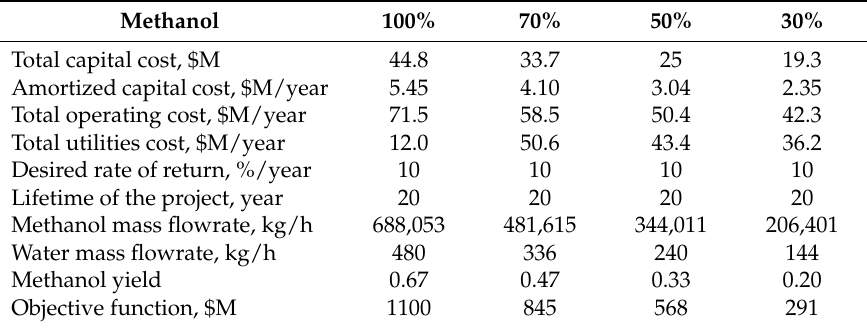
Table 5. Methanol production results for different methane feedstock utilization levels.